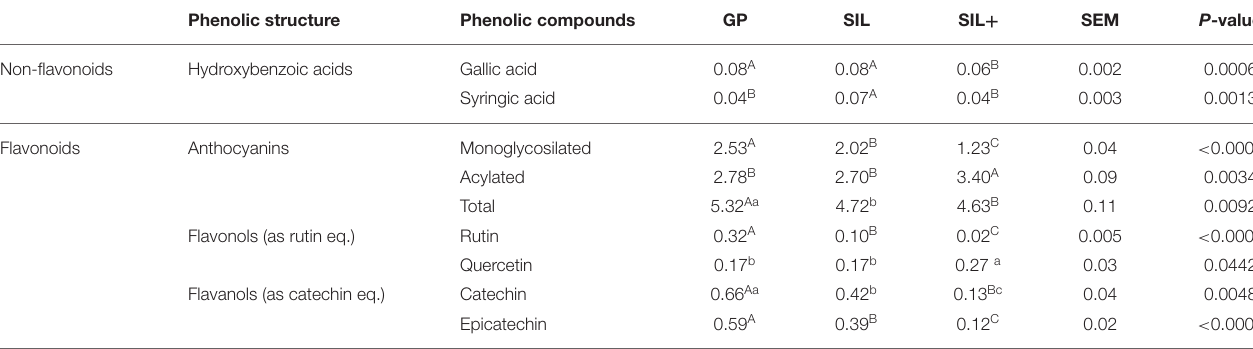
TABLE 3 | Phenolic profile content (mg/g dry weight) in grape pomace (GP), after silage with (SIL + ) or without (SIL) L. plantarum 5BG inoculation, quantified by HPLC analysis ( n = 3). Phenolic structure Non-flavonoids